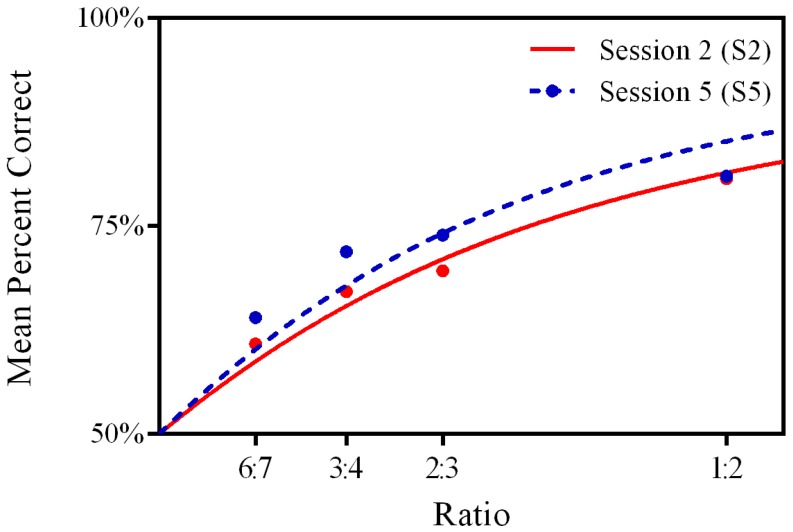
Children’s Performance on the Who Has More Task.Lines show psychophysical model fit.